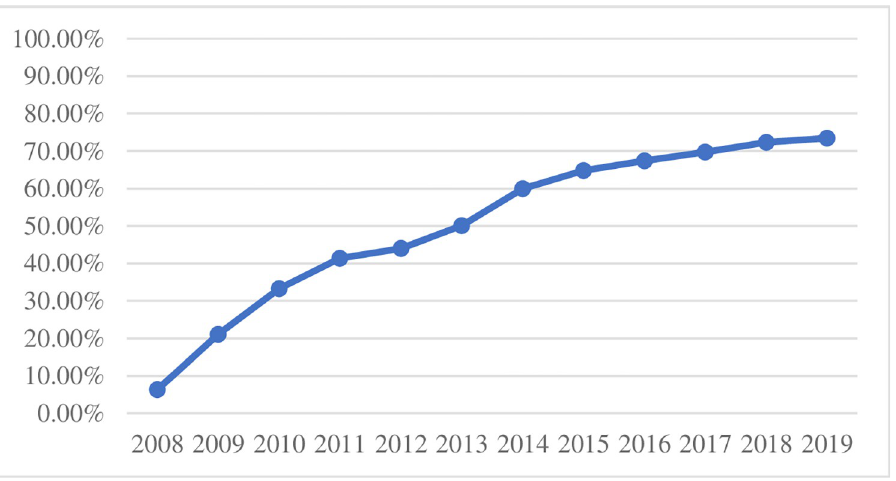
Fig 1. The proportion of companies that have opened high-speed rail in their